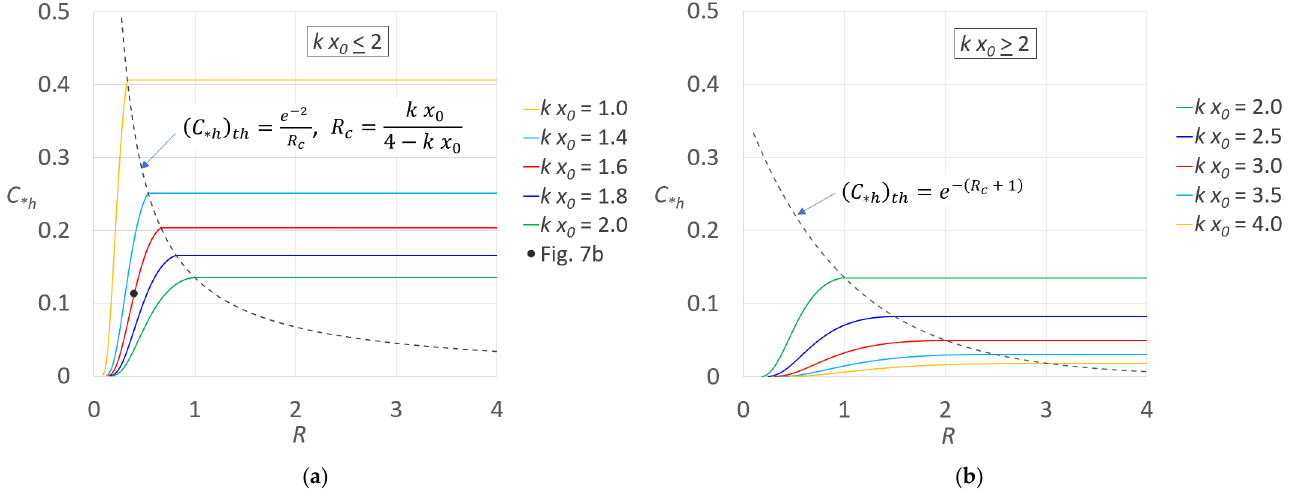
Figure 5. Hydraulic loading rate normalized with respect to v 0 , C *h (Equation (36)) versus the return ratio, R , for ( a ) k x 0 ≤ 2 and ( b ) k x 0 ≥ 2. The limiting C *h conditions (Equation (38) and Equation (39), respectively) are also indicated. In ( a ), the dot corresponds to the application performed later.